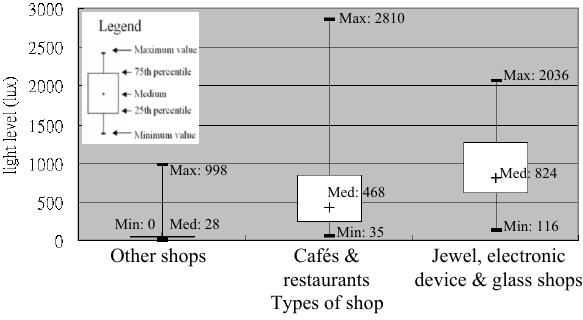
Figure 12. Statistics of SLL for the three types of shops